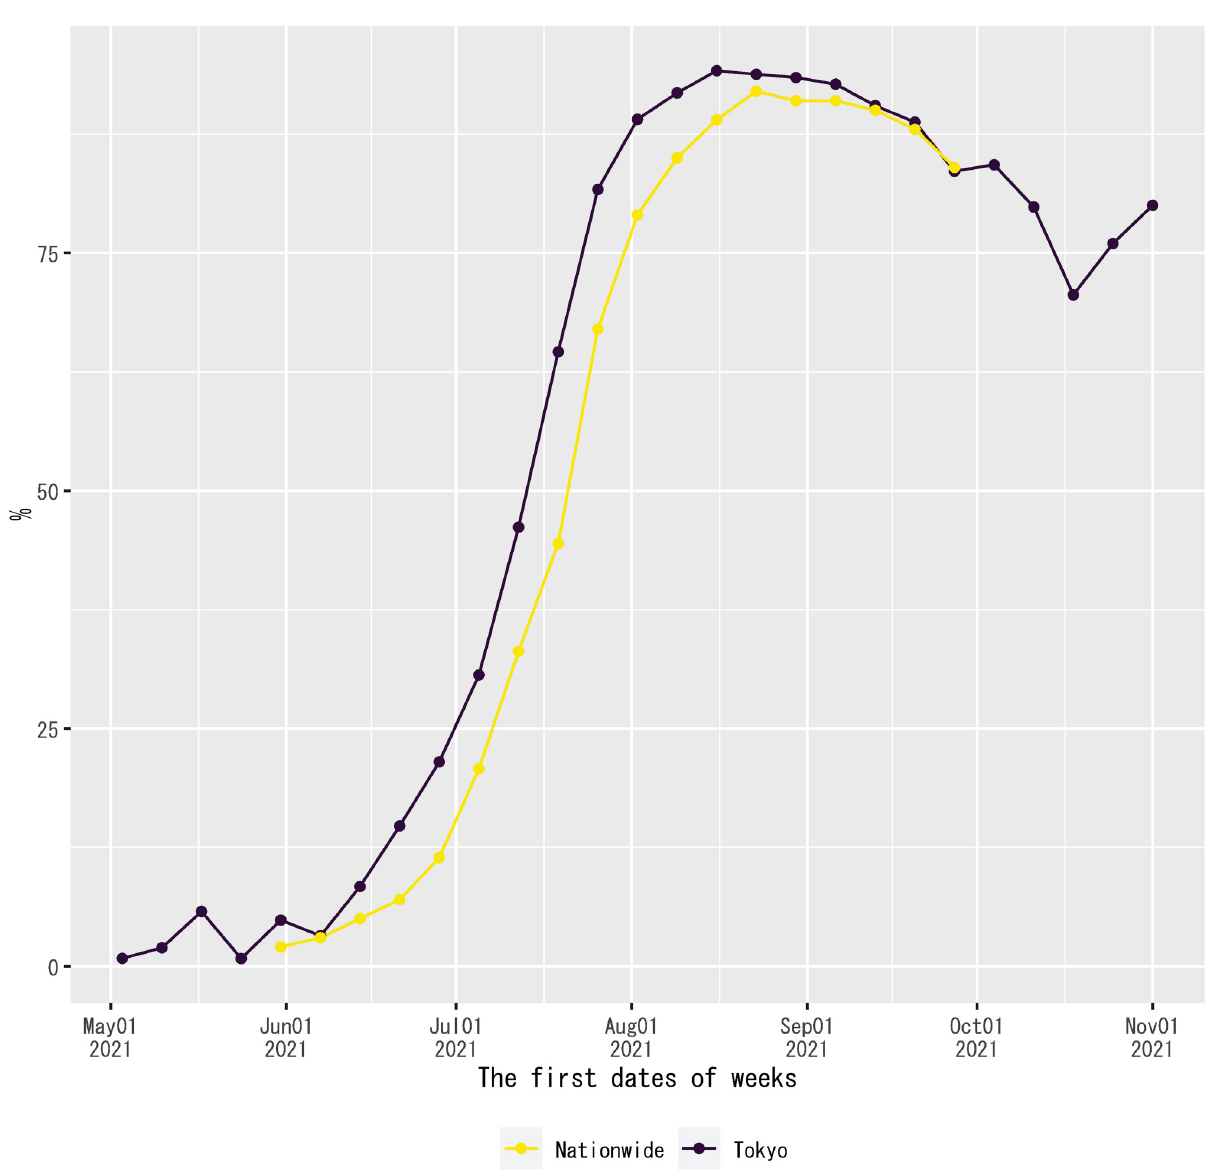
Fig 11. Delta-variant share of new confirmed cases of COVID-19 in Japan. Source: The Ministry of Health, Labour and Welfare, the Government of Japan; and the Tokyo Metropolitan Government [58, 59]. Notes: The Ministry of Health, Labour and Welfare and the Tokyo Metropolitan Government stopped reporting the data after the weeks of Sept. 27, 2021, and Nov. 1, 2021,